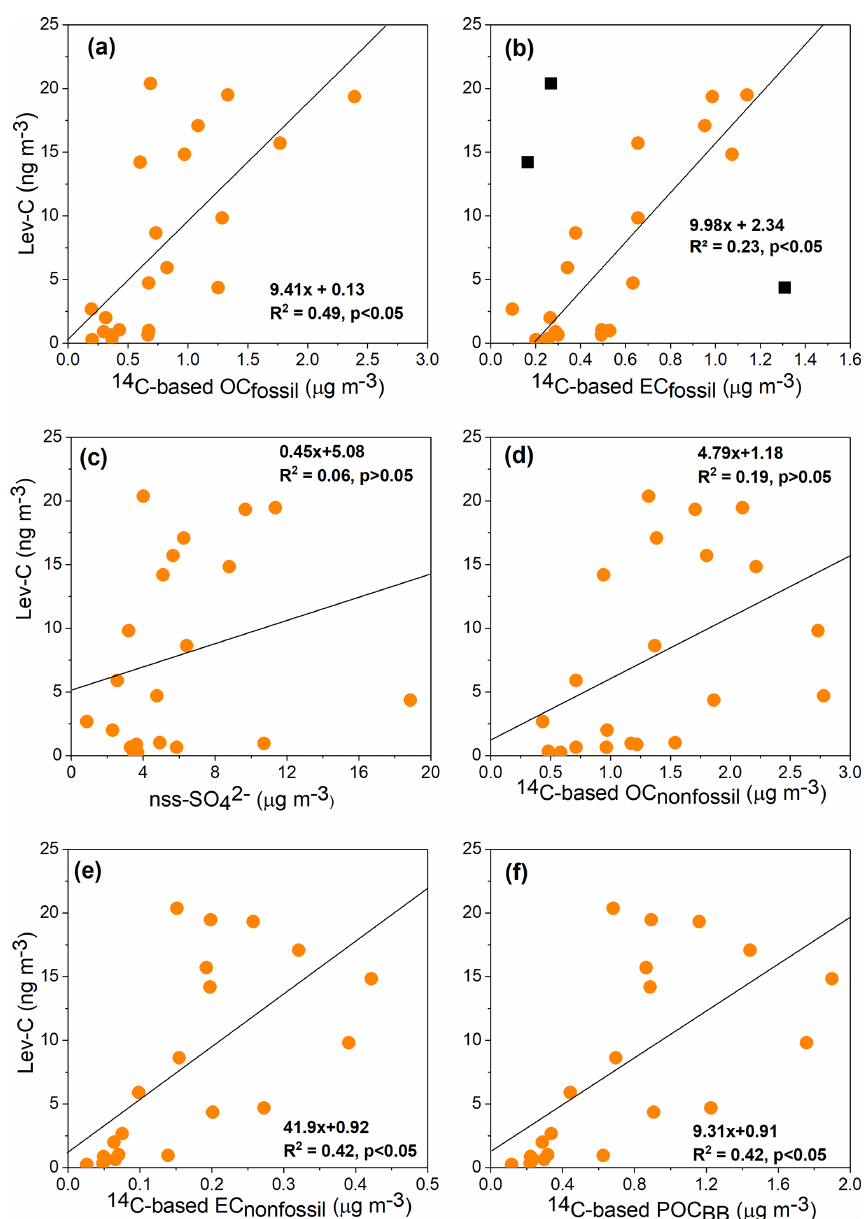
Figure 9. Linear regression analysis between levoglucosan in terms of its carbon content (Lev C) and 14 C-based mass concentrations of (a) organic carbon and (b) elemental carbon of fossil origin (OC fossil and EC fossil , respectively). (c) Values of nss SO 2 − organic carbon (OC nonfossil ), (e) nonfossil-derived elemental carbon (EC nonfossil ), and (f) biomass-burning-derived primary OC (POC BB ) in TSP collected over Gosan during April 2013–April 2014. In panel (b) , the squares represent three outliers (i.e., samples with rather high and low Lev / EC ratios; please see the text for more